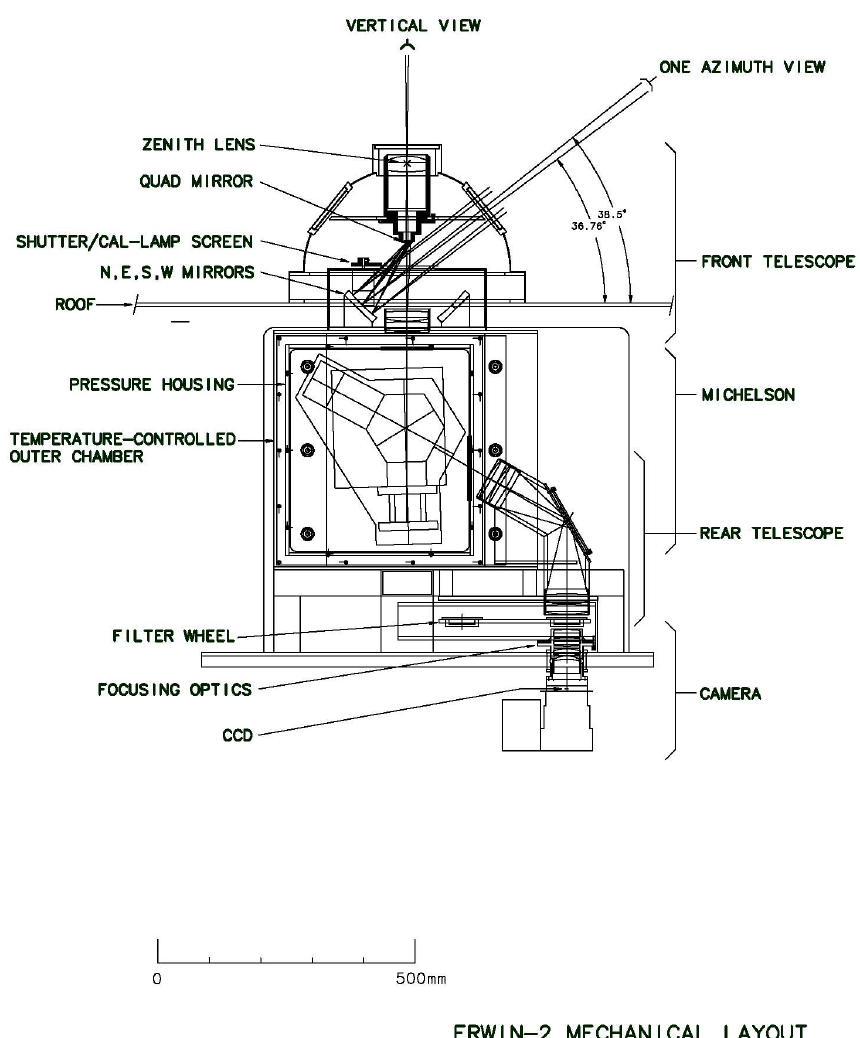
Fig. 1. Diagram of ERWIN mechanical